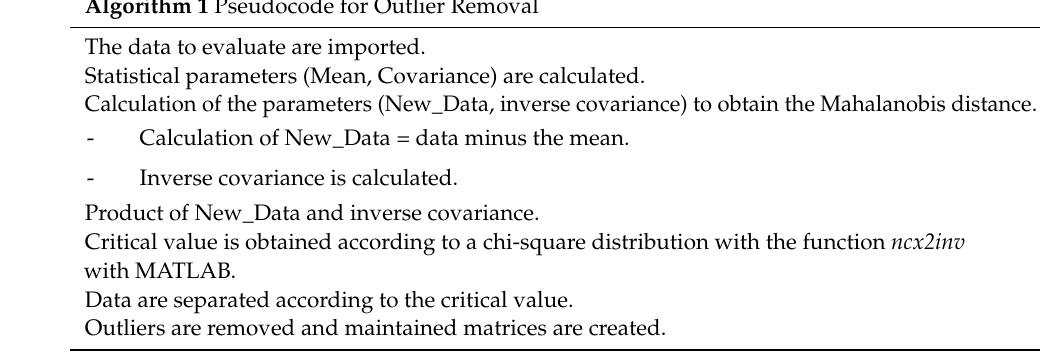
Algorithm 1 Pseudocode for Outlier